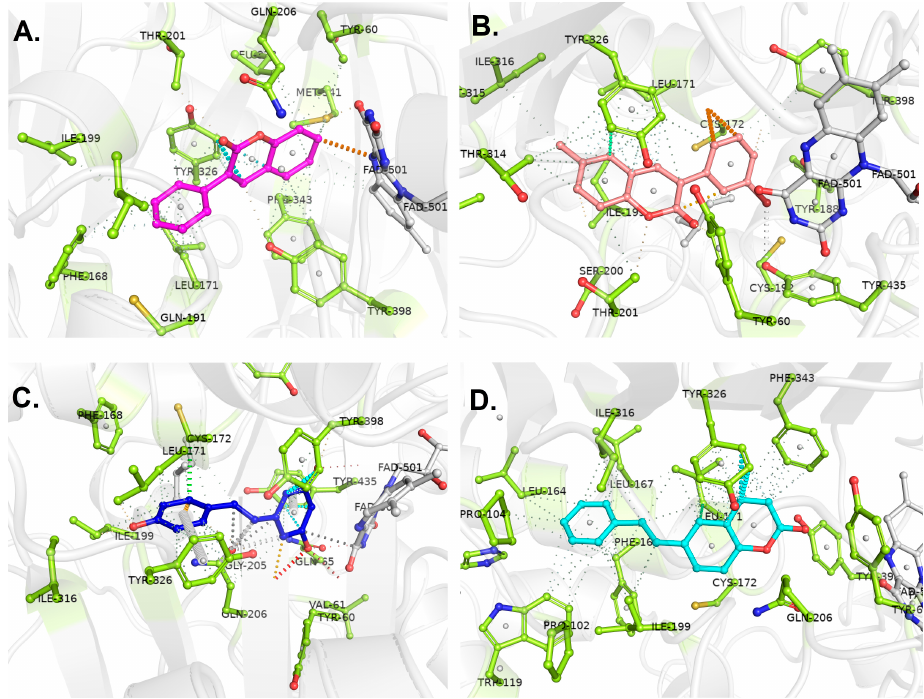
Figure 10. Binding poses of 3-phenylcoumarin ( A ), 3-(3’-bromophenyl)-6-methylcoumarin ( B ), trans -resveratrol ( C ) and trans -6-styrylcoumarin ( D ) at the active site of MAO-B of 100 ns MD simulations.